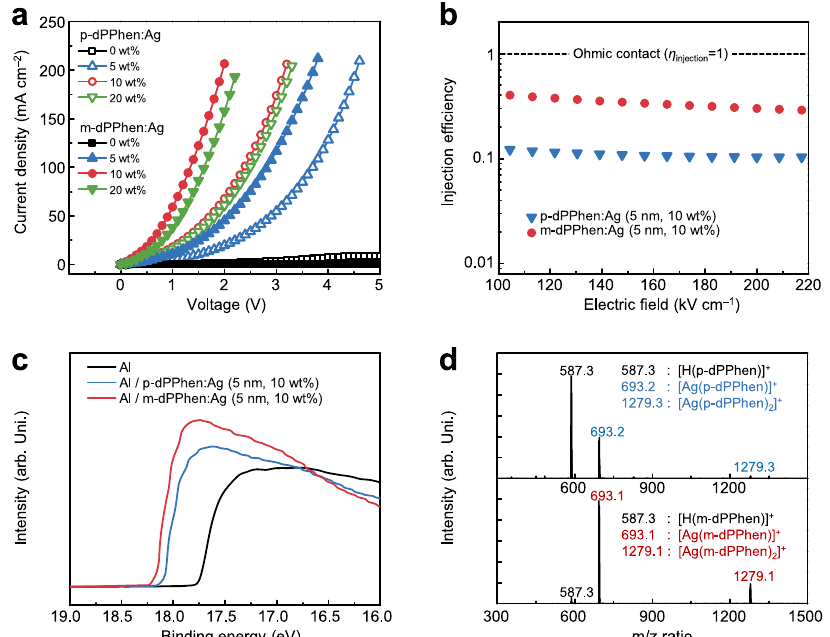
Fig. 3 Characteristics of EILs based on Ag-doped p-dPPhen or m-dPPhen. a The current density ( J ) − voltage ( V ) characteristics of EODs with structures of ITO/Bphen:Cs 2 CO 3 (10 nm, 10 wt%)/DPPyA (100 nm)/p-dPPhen:Ag or m-dPPhen:Ag (5 nm, 0, 5, 10, 20 wt%)/Al (150 nm). b The injection ef fi ciencies of EILs consisting of p-dPPhen:Ag (5 nm, 10 wt%) and m-dPPhen:Ag (5 nm, 10 wt%). c UPS analysis of Al (10 nm), Al (10 nm)/p-dPPhen:Ag (5 nm, 10 wt%) and Al (10 nm)/m-dPPhen:Ag (5 nm, 10 wt%). d Mass spectra of Ag-doped diphenanthroline fi lms of p-dPPhen:Ag (130 nm, 10 wt%) and m-dPPhen:Ag (130 nm, 10 wt%). The molar ratio of diphenanthroline ligand:Ag is 1.84:1, and the doping concentration is 10